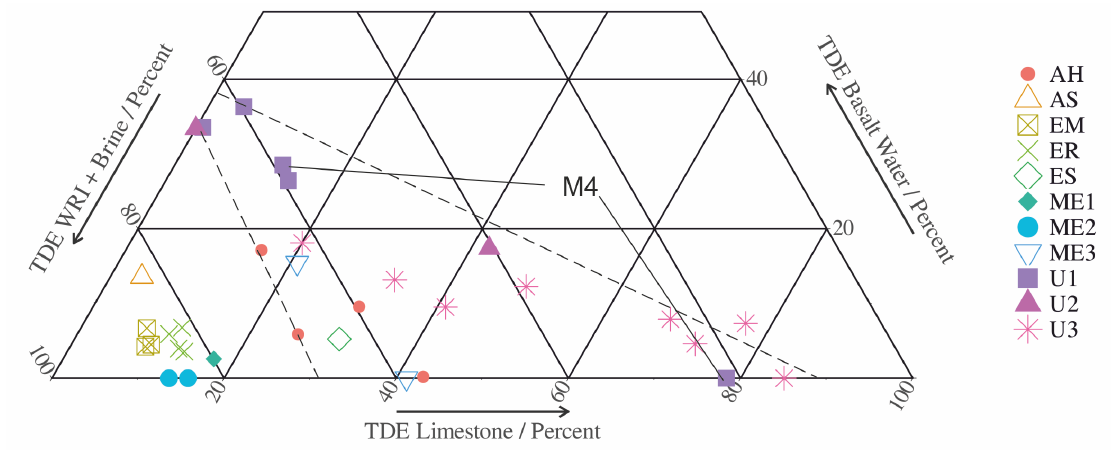
Figure 11. Ternary plot of contributions in %TDE of basaltic-rock-water, limestone water and WRI+brine. Several trends evolve. All trends seem to culminate in the Yarmouk River water. The dashed lines fix the array of Mukheibeh, Ain Himma, Mezar 3 and Ein Sahina. Clearly separated, the waters from Hammat Gader (EM, ER); Mezar 1 and 2; and Ain Saraya cluster in the lower left corner. With M4, a subgroup is indicated within the Mukheibeh U1 group (code refers to Table 3) visualizing the possibility of high variation in composition of groundwater from one and the same